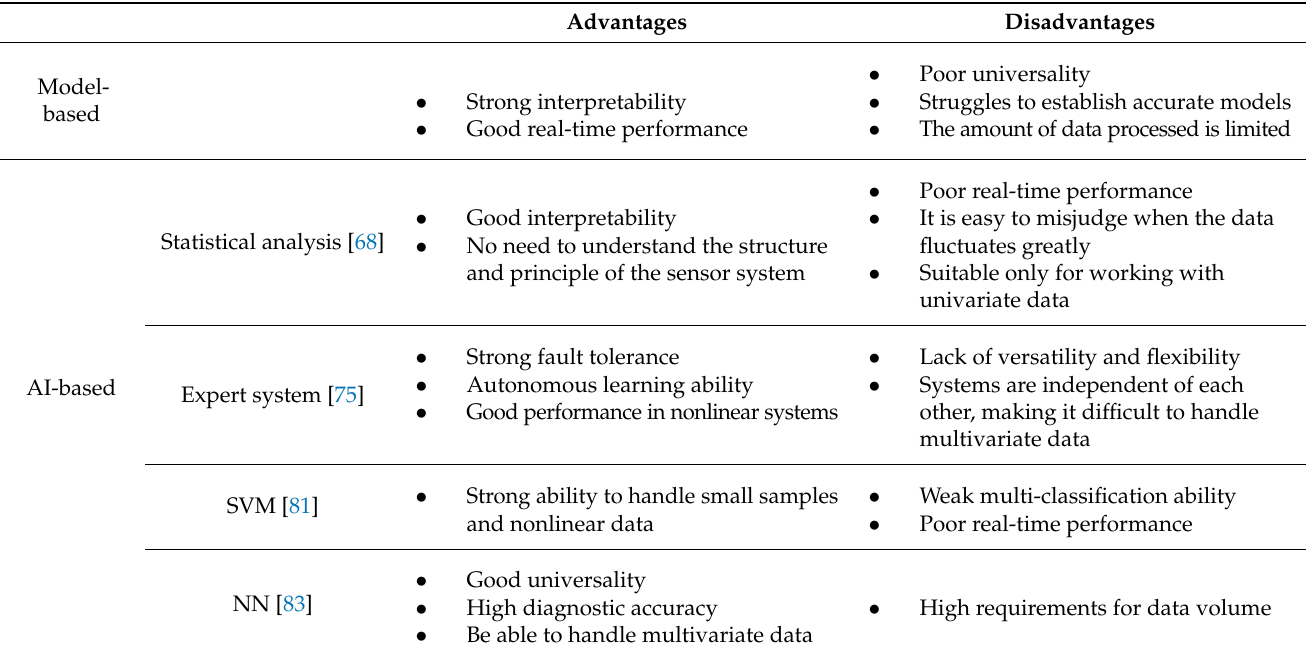
Table 4. Comparison of advantages and disadvantages of intelligent fault diagnosis methods.